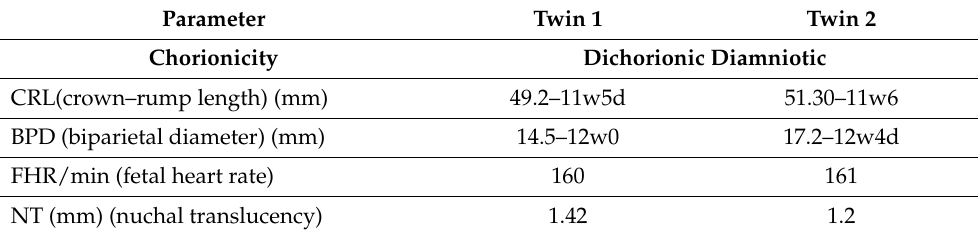
Table 2. First trimester scan.